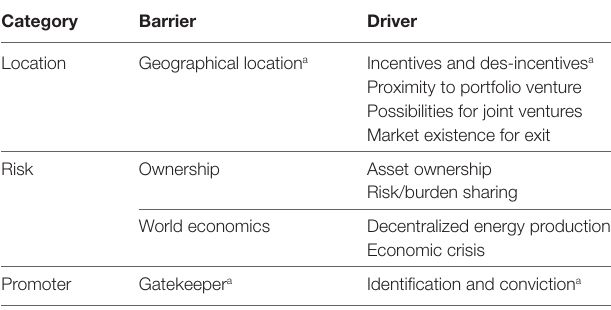
TaBle 4 | Overview of cross-linkage barriers and